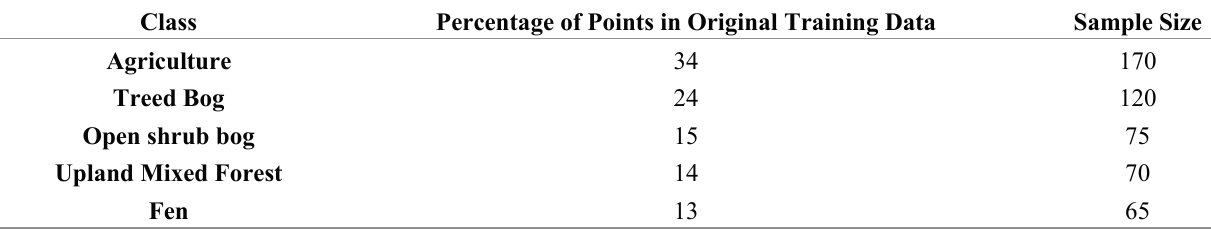
Table 5. Actual proportions of each class in training